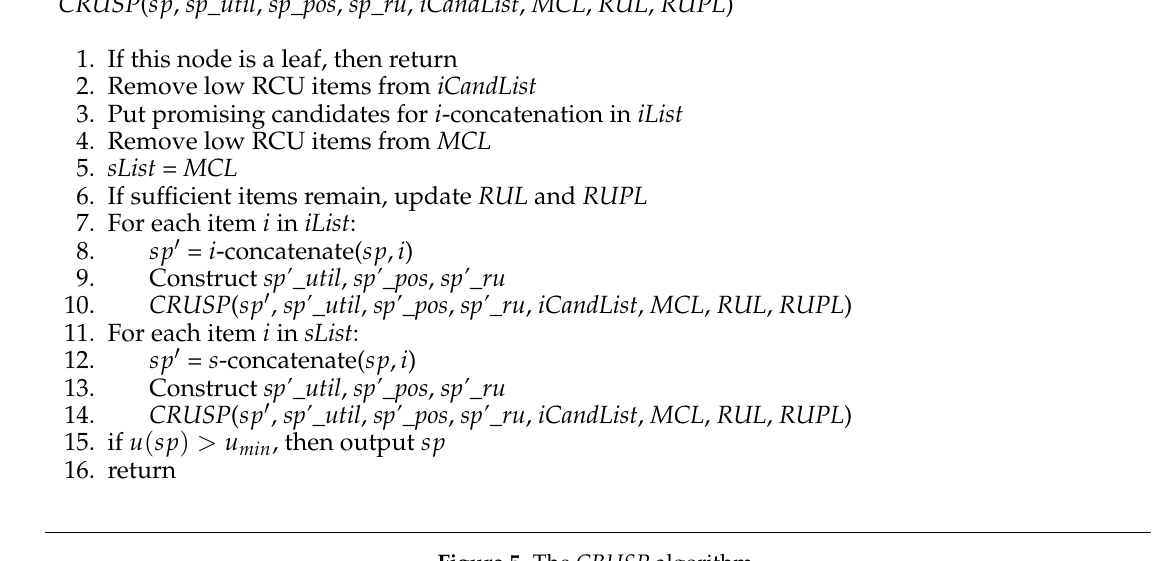
Figure 5. The CRUSP